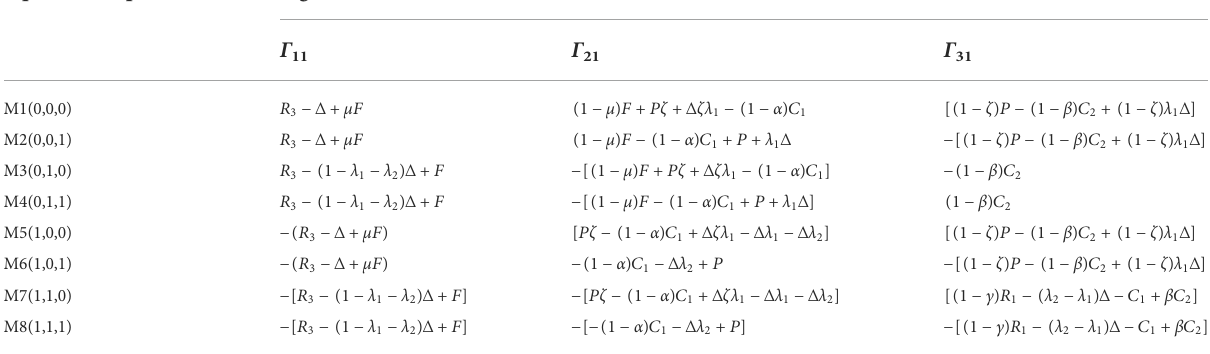
TABLE 3 Eigenvalues of the equilibrium points. Equilibrium point